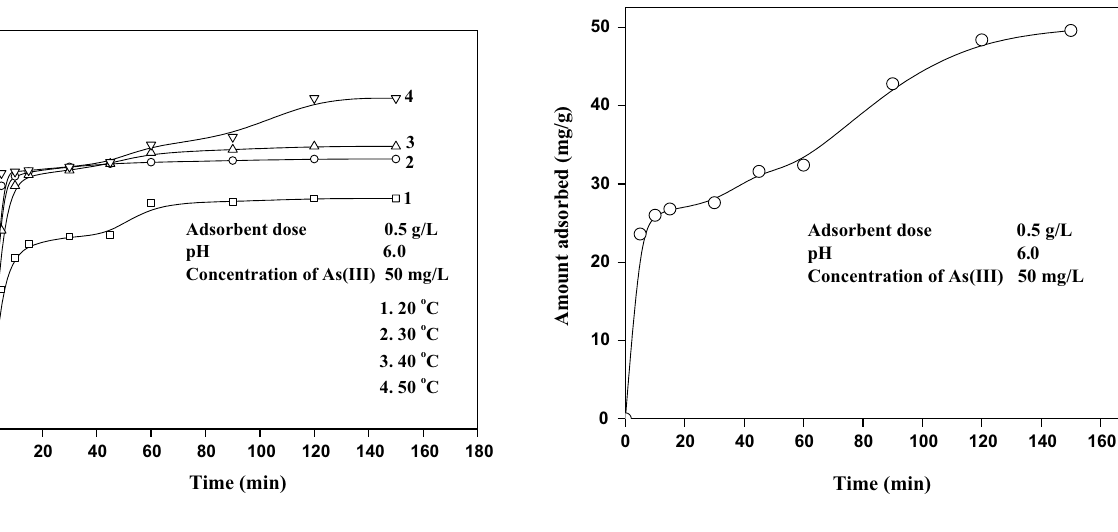
Fig. 3 Effect of temperature Fig. 4 Effect of As(III) in the presence of other